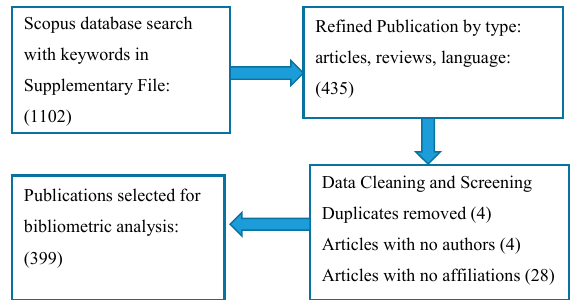
Figure 1. Graphical representation of data processing.